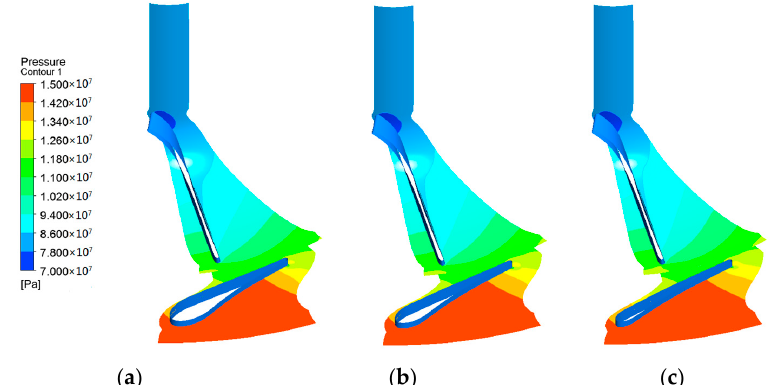
Figure 11. Pressure contours at the mid-span of the impeller and nozzle: ( a ) LED = 10 mm; ( b ) LED = 7 mm; ( c ) LED = 4 mm.